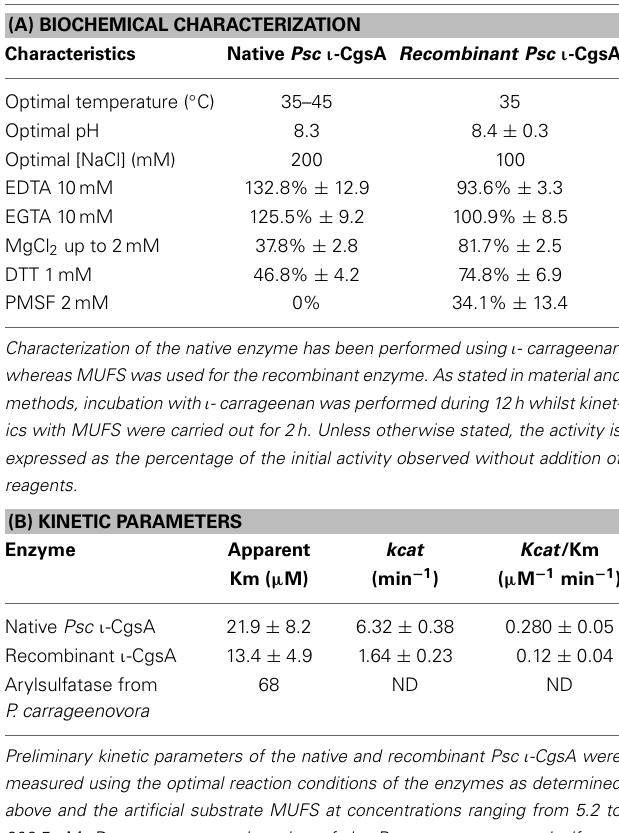
Table 3 | Characterization of the native and the recombinant Psc ι